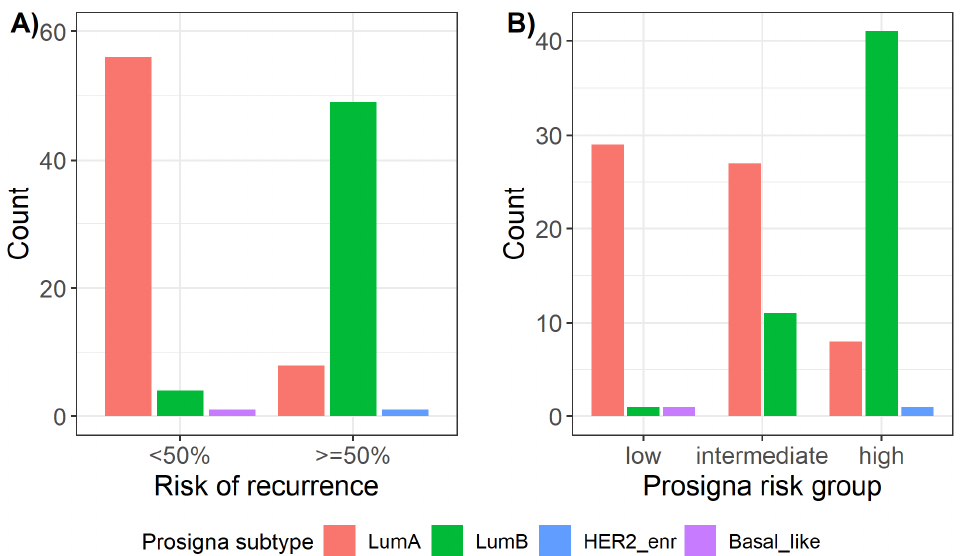
Figure 2. Distribution of Prosigna®subtypes across ( A ) Prosigna®risk of recurrence and ( B ) Prosigna®risk groups. HER2_enr = HER2-enriched; LumA = Luminal A; LumB = Luminal B. Prosigna®risk group was found to be significantly correlated also with both IHC and IHC+G subtypes (Figure 3), with Prosigna®high risk group being positively associated with Luminal B subtype and negatively associated with Luminal A subtype ( p -value = 0.007 and p -value = 0.015, respectively, for IHC and IHC+G subtypes).